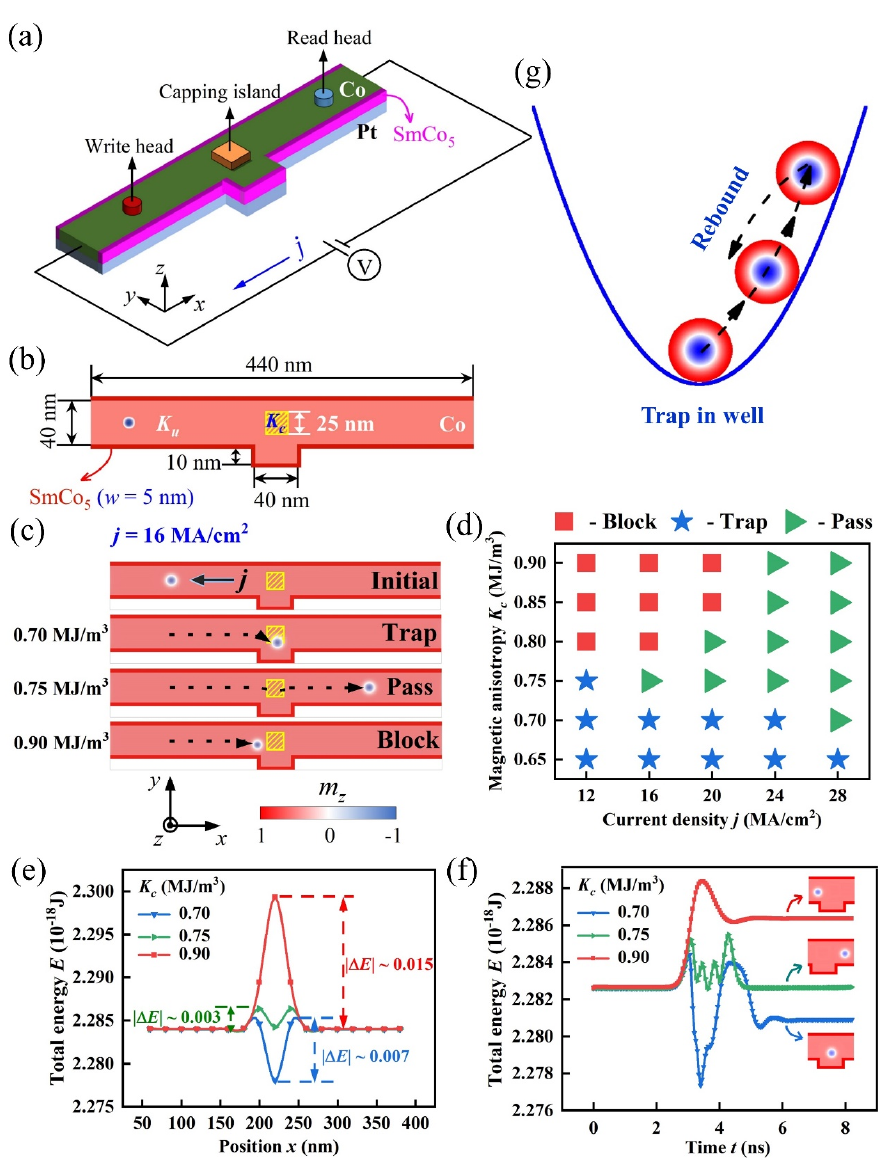
Figure 3. ( a ) Sketch of a racetrack memory with Co/Pt nanotrack. ( b ) Schematic view of nanotrack on the xy -plane with inhomogeneous PMA distribution. ( c ) The skyrmion movements in the nanotrack driven by spin current with density j = 16 MA/cm 2 . The initial state and the different final states of skyrmion motion (‘block’, ‘trap’ or ‘pass’) at various K c , with the movement trajectories marked by the dashed lines. ( d ) The state diagram illustrates the condition for the different final states of the skyrmion under various j and K c . ( e ) Plots of the total energy E of the whole nanotrack as a function of the position x where the skyrmion is located in the nanotrack at various K c . Here the depth/height of potential well/barrier was denoted as | Δ E |. ( f ) Plots of the varying E as a function of simulated time t for the three typical cases in panel ( c ). Inserts indicate the corresponding final states of skyrmion motion. ( g ) Schematic draw of the skyrmion rebound movement in the potential well for the ‘trap’ state.